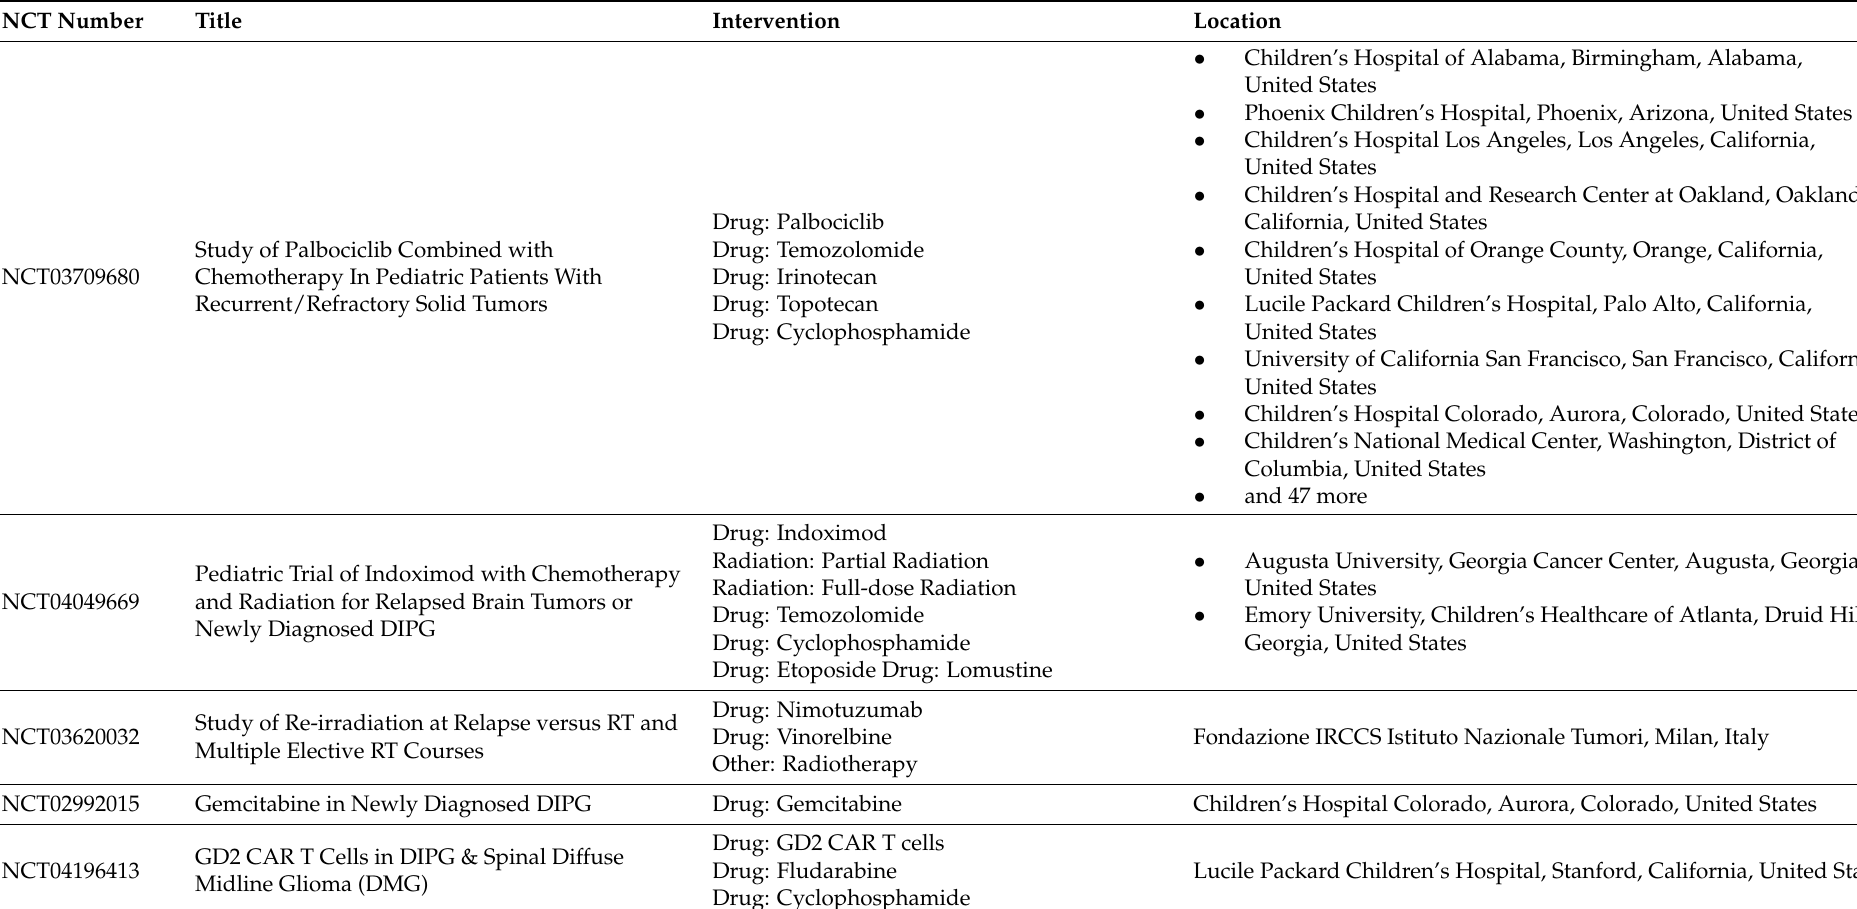
Table 2. Active clinical trials for children with diffuse intrinsic pontine glioma involving chemotherapy as found on www.Clinicaltrials.gov as of 12 January